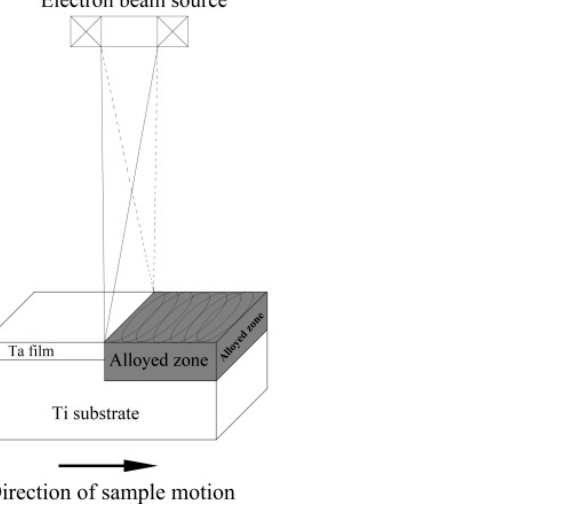
where a nanomechanical tester (Bruker, Billerica, MA, USA) was used. The number of load was 200